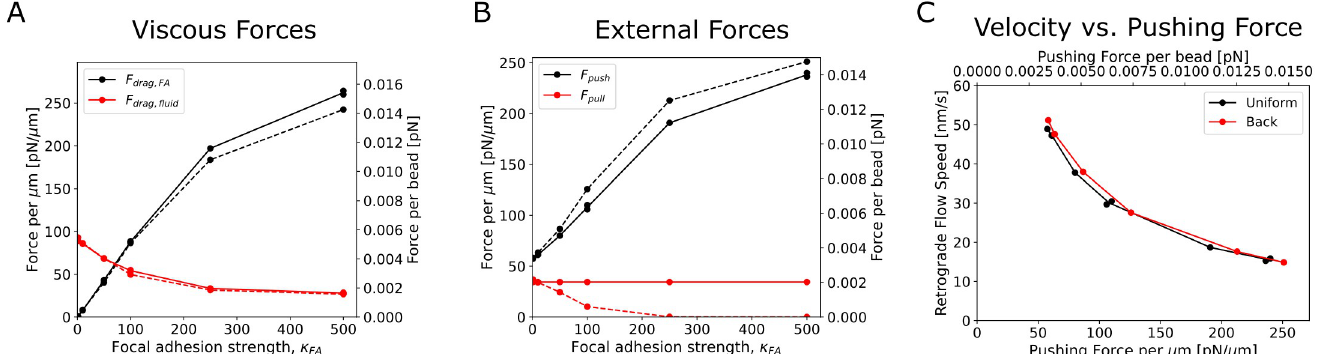
Fig 4. Force balance in the actin network changes as the focal adhesion strength increases. Forces in these plots are the net force on the actin network divided by either the leading edge width of 2 μm (force per μm ) or per number of actin beads in the simulation (force per bead). (A) Viscous forces versus focal adhesion strength. Drag due to the focal adhesion region increases as focal adhesion strength increases while that due to the surrounding fluid decreases for both pull uniform (solid lines) and pull back (dashed lines) modes. (B) External forces versus focal adhesion strength. As the focal adhesion strength increases the pushing force increases and, for the pull uniform case, the pulling force decreases to zero. The pulling force per bead is, by definition, fixed in the uniform case so it remains constant. (C) Retrograde flow speed as a function of the external pushing force. Higher pushing forces and lower retrograde flow speeds correspond to higher focal adhesion strengths. Plot shows a decreasing, convex curve. In all panels, forces are shown as per bead in the lamellipodium or as force per μm along the leading edge. To check reproducibility, replicates were run for κ = 100 and 500 in the pull uniform case and shown with separate data points in all panels; little variance was seen FA in the forces or retrograde flow speed between the two runs. All data calculated from simulations equilibrated for at least 225 s and averaged over at least 30 s.